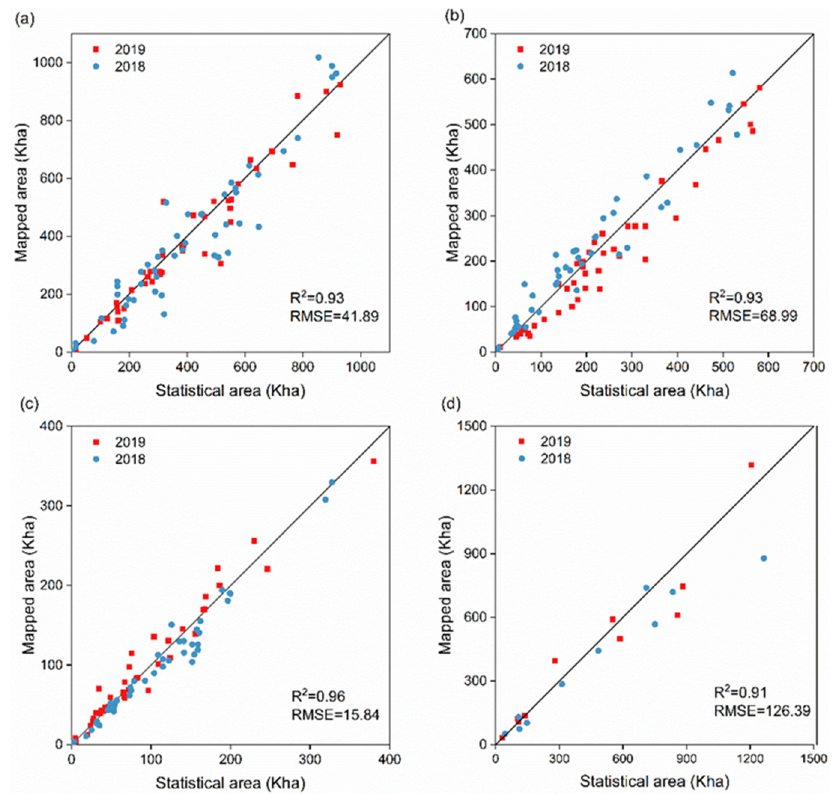
Figure 5. Comparisons between the mapped and statistical areas at NUTS-2 level (except for spring Triticeae crops at country level) in 2018 and 2019 for ( a ) winter Triticeae crops, ( b ) maize, ( c ) rapeseed, and ( d ) spring Triticeae crops. Table 3. Classification accuracy of the point-based validation for England and the Netherlands.